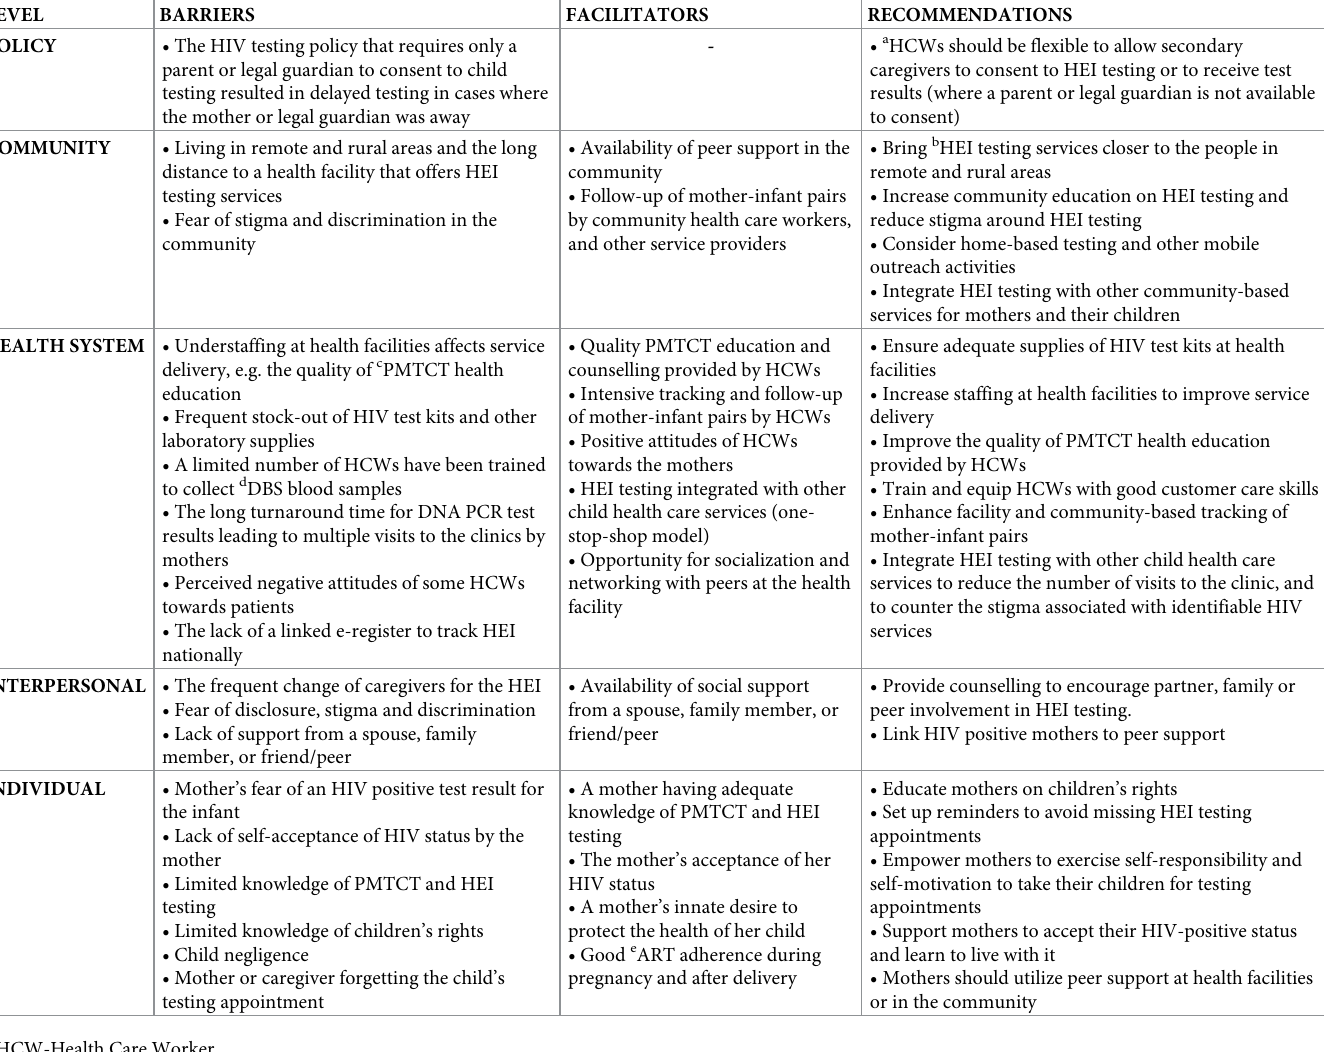
Table 2. Summary of HIV positive mothers’ perspectives on facilitators, barriers and recommendations to promote HIV exposed infant testing.